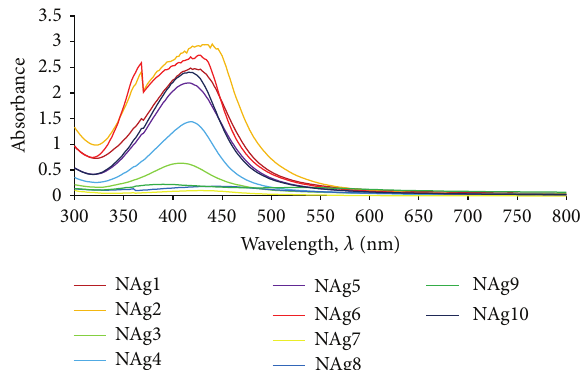
Figure 5: Spectrophotometric spectra obtained for a suspension of silver based on an extract of dog